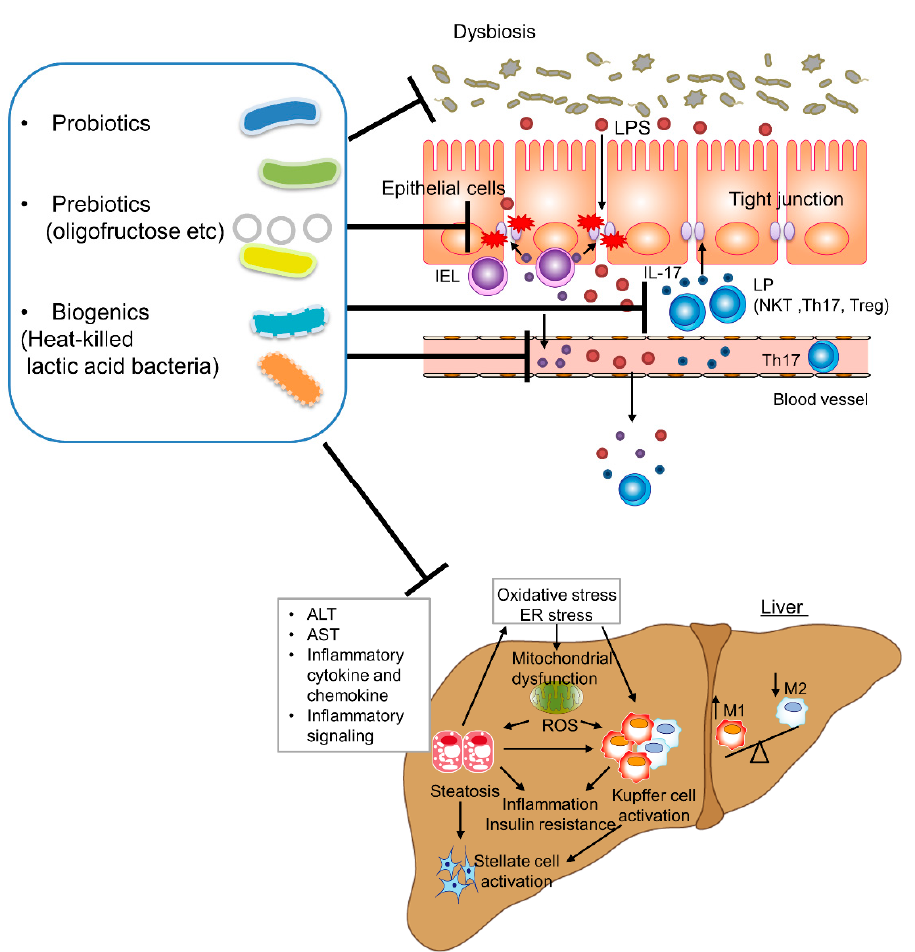
Figure 3. Schematic representation of the beneficial effects of probiotics, prebiotics (e.g., oligofructose), and biogenics (heat-killed lactic acid bacteria) on NAFLD and NASH progression by regulating the intestinal environment and reducing hepatic inflammation, lipid accumulation, and fibrosis. In NAFLD and NASH, probiotics, prebiotics, and biogenics suppress tight junction dysfunction and enhance intestinal epithelial permeability. Increased intestinal permeability or ‘leaky gut’ results in metabolic endotoxemia followed by low-grade inflammation in the liver. Probiotics, prebiotics, and biogenics ameliorate NAFLD and NASH by preventing leaky gut and metabolic endotoxemia due to tight junction dysfunction, and by depressing oxidative stress, inflammation, and fibrosis in the